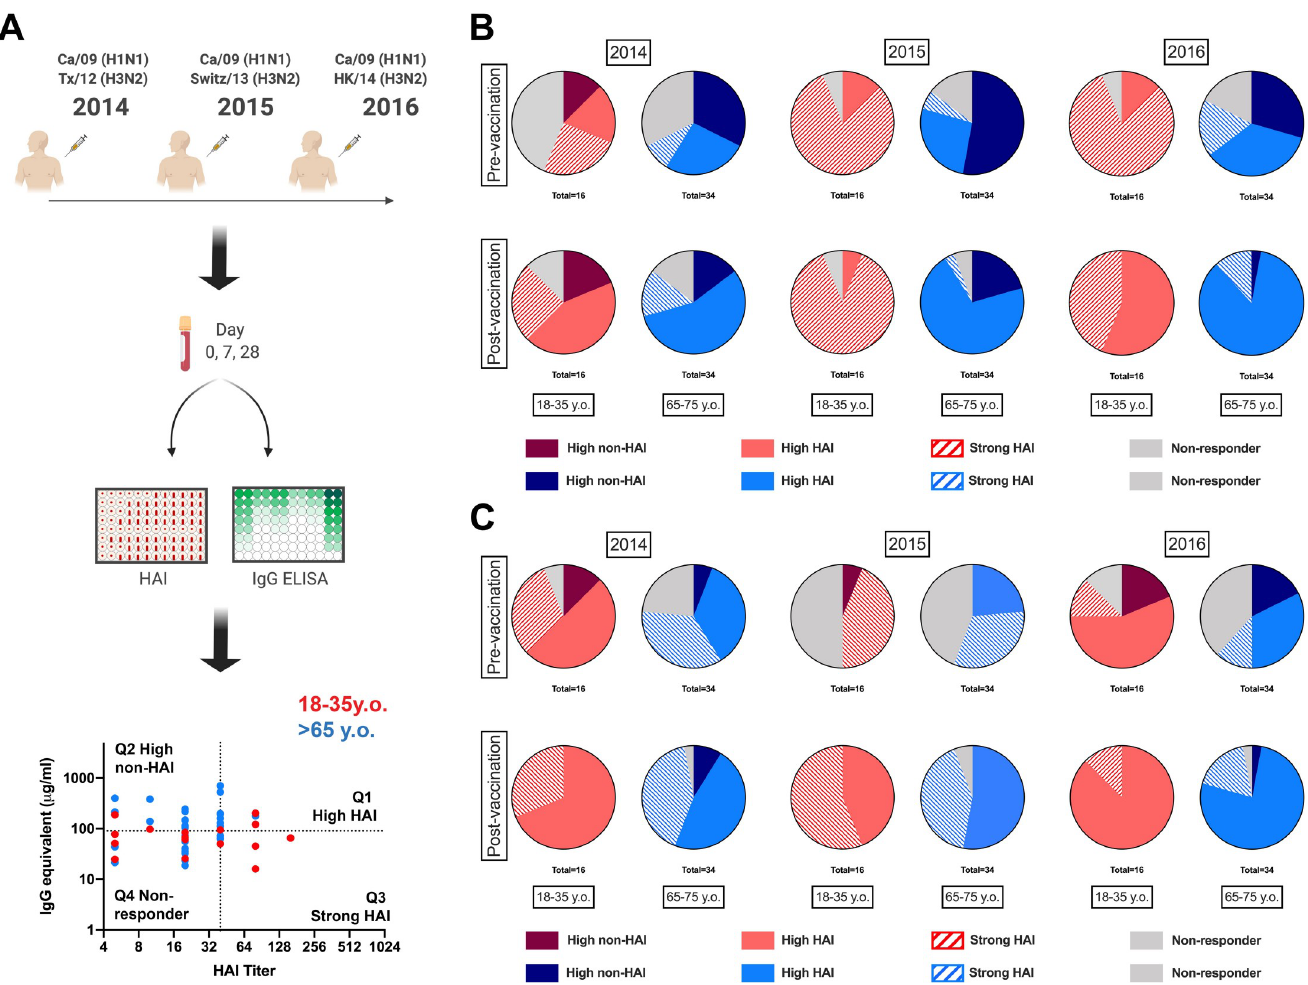
Fig 1. Changes in serological antibody profile following recurrent influenza vaccination. A) General experimental approach for serological profiling. 50 participants (16 young-adult and 34 elderly) were vaccinated for three consecutive years with standard of care inactivated influenza vaccine and serum samples collected prior to and 21–28 days post-vaccination. Serum samples were tested for hemagglutination inhibition (HAI) activity against the H1N1 and H3N2 vaccine virus strains as described in M&M section. In parallel total rHA-reactive IgG-antibodies were quantified by ELISA as described in the M&M analysis. Biparametric quadrant analysis of each subject’s HAI titer and rHA-specific IgG ( μ g/ml) identified participants with High-HAI antibodies in Q1, high non-HAI in Q2, strong-HAI in Q3 and non-responders in Q4. B) Changes in H1N1-reative serological antibodies in young-adult (red) and elderly (blue) participants vaccinated for three consecutive years, measured as in A. C) Changes in H3N12-reative serological antibodies in young-adult (red) and elderly (blue) participants vaccinated for three consecutive years, measured as in A. Changes in the proportion of participants in each quadrant over time were assess by Chi-square test ( χ 2 ).